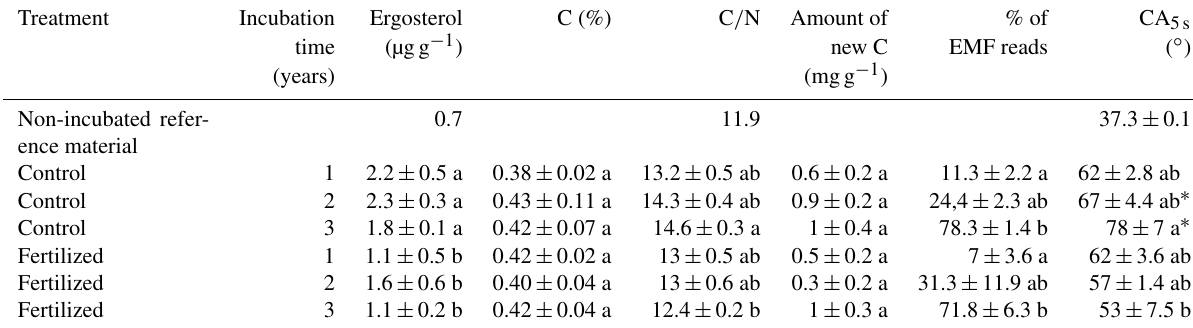
Table 1. Average and standard error of the ergosterol concentrations, total C%, C / N ratio, amount of new carbon (C 3 mainly from EMF species), percentage of EMF DNA reads and contact angle determined 5s after placement of water droplets placed on mesh bags material amended with maize compost (CA 5s ; estimation of contact angle stability). Low score letters refer to statistical differences according to the post hoc Tukey test and pairwise Dunn test. Asterisks correspond to statistical differences for CA after 5s between the mesh bag contents and the non-incubated reference material.